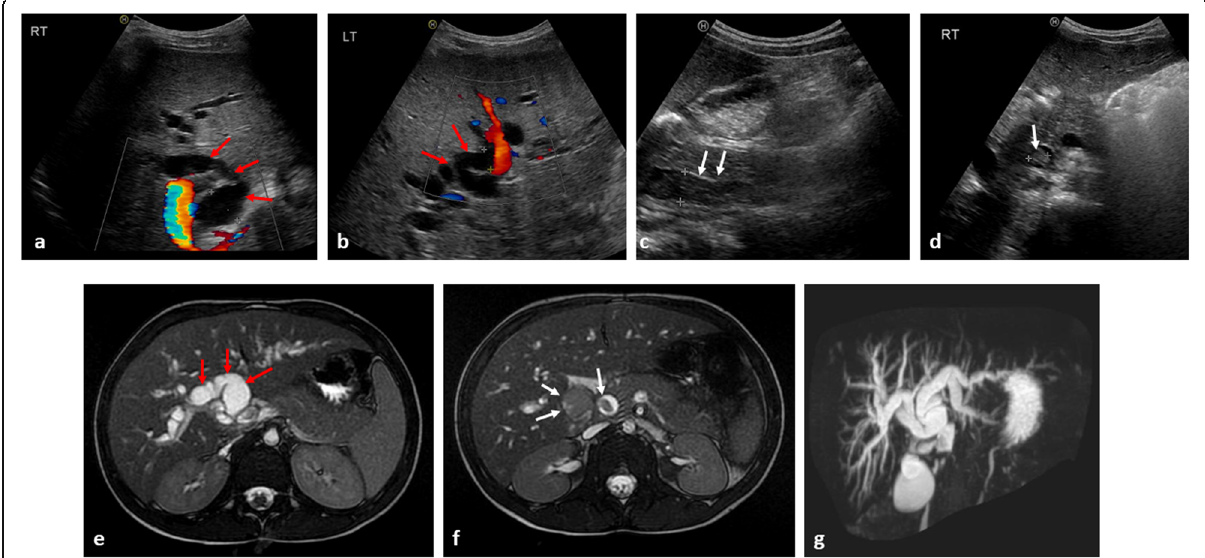
Fig. 16 A 6-year-old girl, also presenting with jaundice from a biliary rhabdomyosarcoma. a , b Transverse ultrasound images at diagnosis reveal marked intrahepatic biliary ductal dilatation (red arrows) measuring > 1 cm in diameter within both the right and left hepatic lobes. c , d Upon careful assessment of the common bile duct to its origin, a homogenous intra-ductal mass is identified (white arrows). e , f Axial T2-weighted MRI images through the liver, subsequently confirm the intrahepatic ductal dilatation (red arrows), with intra-ductal mass (white arrows) in keeping with the biliary rhabdomyosarcoma . g The 3D-MIP from the MRCP again helps to demonstrate the extent of the intrahepatic biliary ductal dilatation. In this clinical scenario, compared to the images of Fig. 15, the intra-ductal mass is harder to visualise on ultrasound without careful assessment of the common bile duct to its origin, highlighting the importance of careful assessment and patience to ensure all pertinent findings are